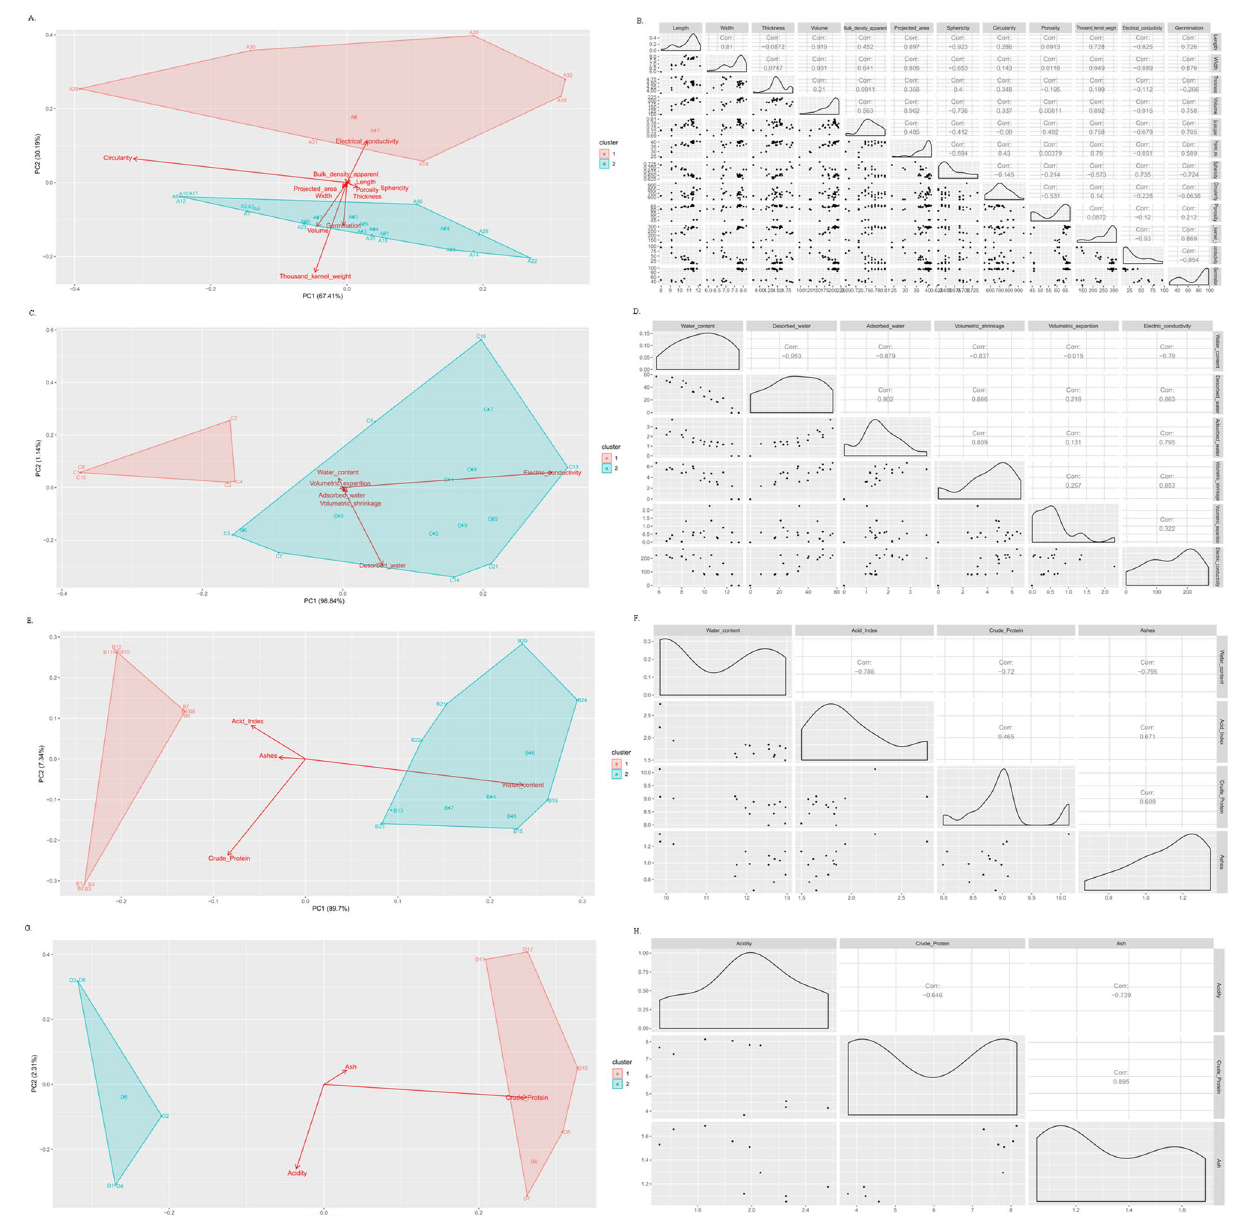
Figure 5. Principal component analysis ( A physical quality, E physicochemical quality) and Pearson’s correlations ( B physical quality, F physicochemical quality) of the effects of the whole, broken, and normal corn grain lots stored for different times under different storage conditions in hermetic systems, aerated and non-aerated metal silos, and bags on the physical quality. ( C ) Principal component analyses and ( D ) Pearson’s correlations of the effects of the initial water content of the grains and temperature of the drying air on the variations in water desorption and adsorption as a function of storage time and physical quality of the corn grain lots. ( G ) Principal component analyses and ( H ) Pearson’s correlations of the effects of the drying air temperature, environment, and storage time on the physicochemical quality of the corn grains.